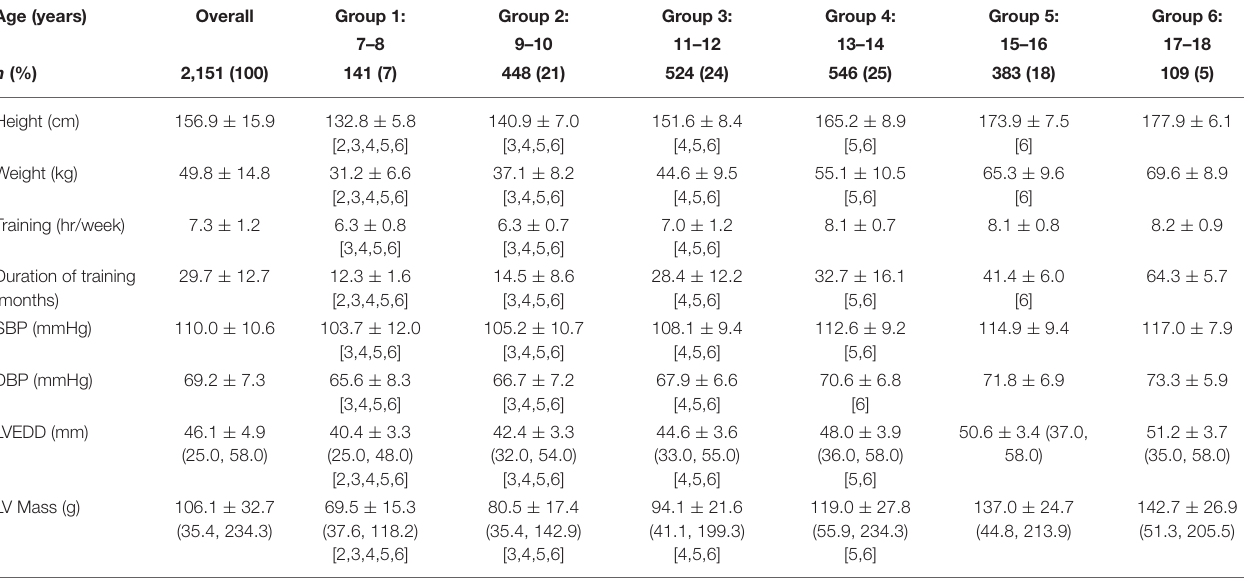
TABLE 1 | Demographic, anthropometric and echocardiographic measurements of the study